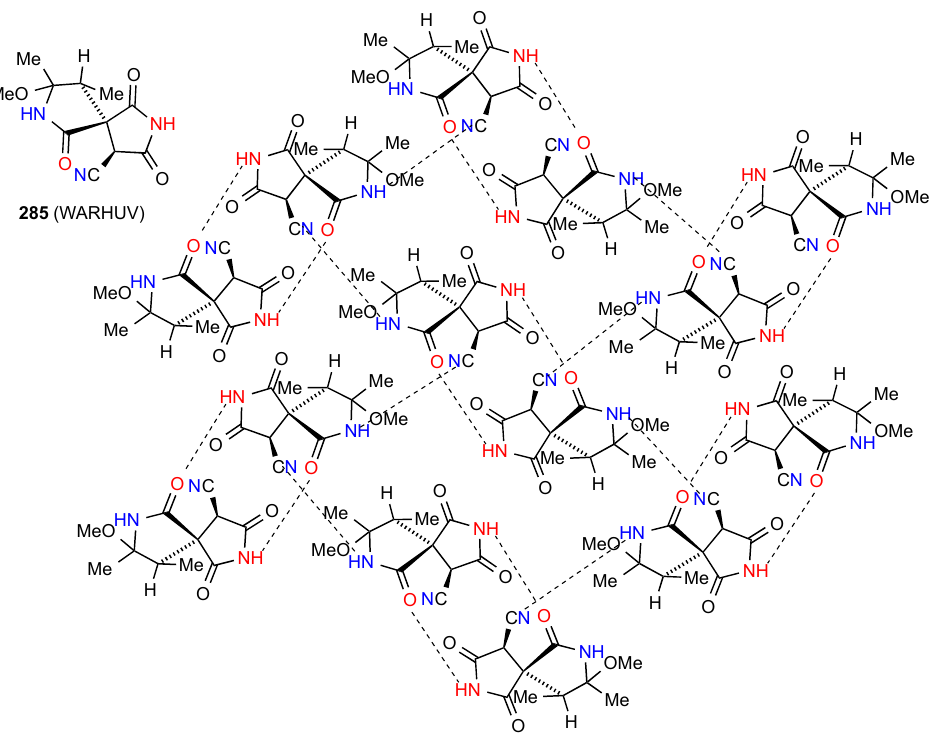
Figure 81. Structure adopted by compound 284.